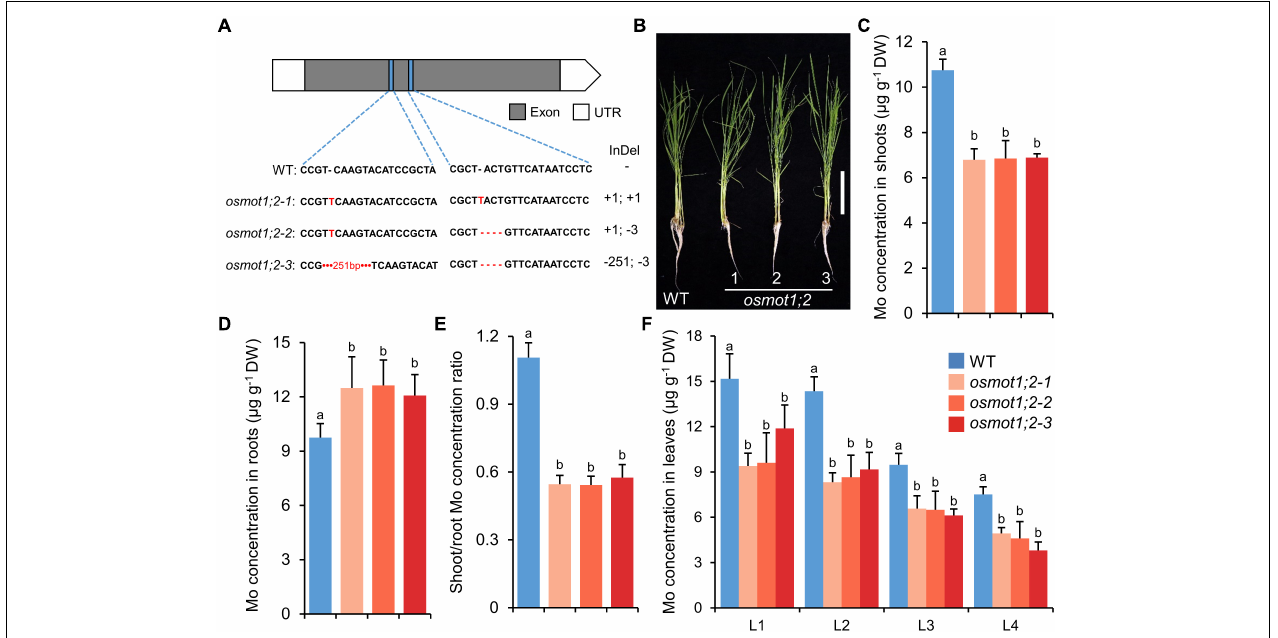
FIGURE 3 | Knockout of OsMOT1;2 reduces the root-to-shoot translocation of Mo. (A) Schematic diagram of three knockout lines of OsMOT1;2 . Blue rectangles represented the sgRNA target sites on the OsMOT1;2 exon, and the sequences are shown below. Nucleotide deletion is indicated by red dashes; short and long insertions are indicated by red letter and red number, respectively. (B) The growth phenotype of WT and three knockout lines of osmot1;2 cultured with nutrient solution with 10 nM Mo at four leaves seedling stage. Vertical bar, 10 cm. (C–E) The Mo concentrations in shoots (C) , roots (D) , and the shoot/root concentration ratio (E) of the seedlings are described in (B) . (F) The Mo concentrations in different leaves of the seedlings in (B) . L1, L2, L3, and L4 represent leaves at different positions. Data in (C–F) are presented as means ± SD with five or six biological replicates. Columns with different letters in (C–F) indicate significant differences at P < 0.05 (Tukey’s honestly significant difference